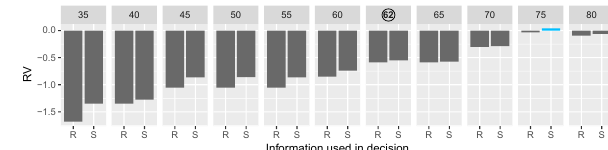
Figure 7. Total Relative Value for the period 2001–2014 for deci- sions informed by reservoir level alone (R) and with the addition of snow information (S) for the 10 sets of thresholds and the optimized thresholds (labelled as 62).